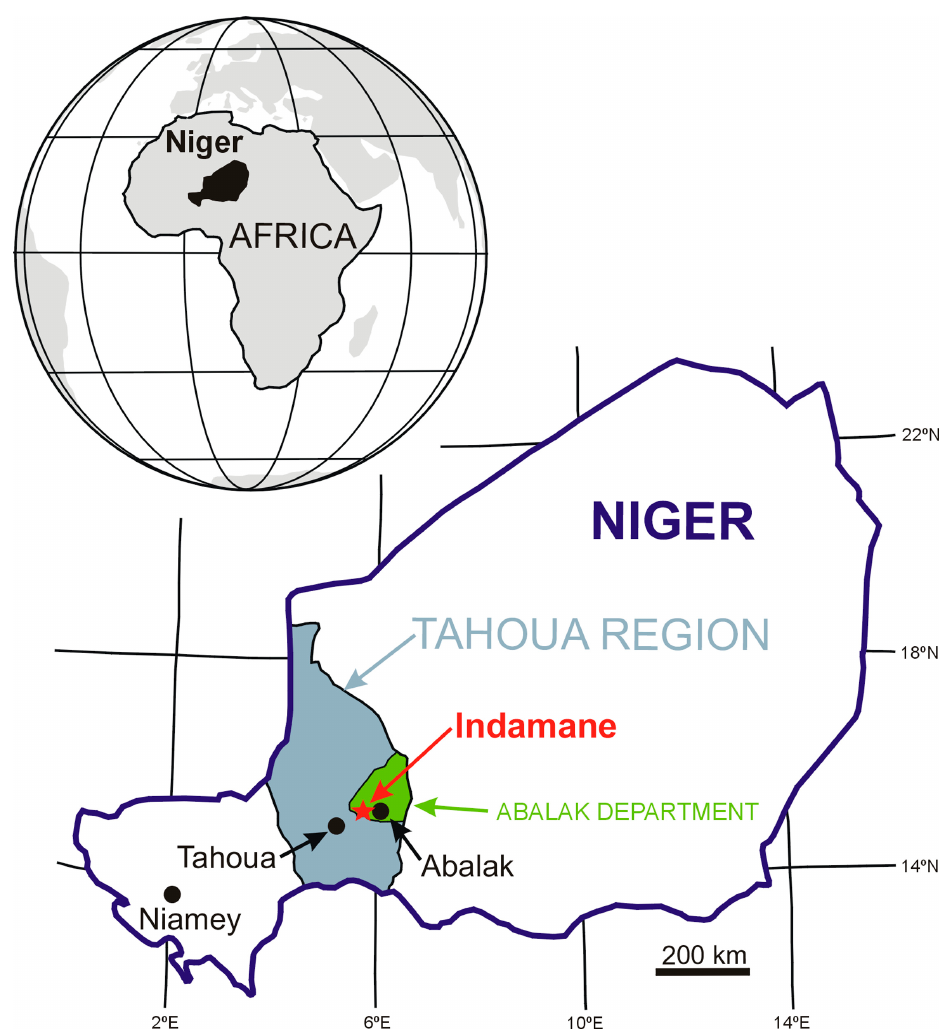
Figure 1. Geographical location of the paleontological area of the Indamane Mount (Abalak Department, Tahoua Region, Southwestern Niger), the type locality of the upper Maastrichtian (Upper Cretaceous) pleurodiran bothremydid turtle Abalakemys chapmanae gen. et sp. nov. Modified from Ref.